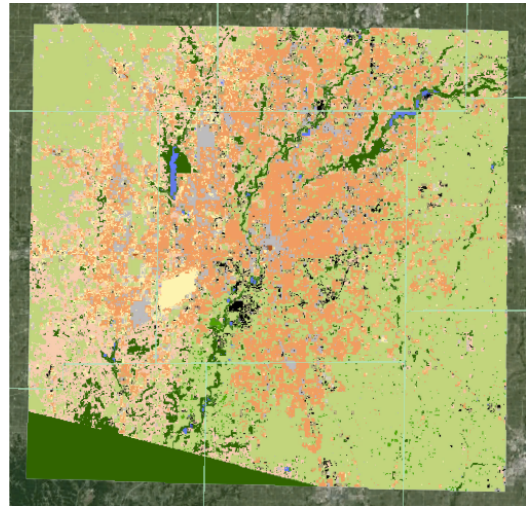
Figure 1: Land use map of Indianapolis and the surrounding area using LCZ framework. The orange represents urban/suburban areas and the green represents rural/forested areas. Map Credit: Oscar Brousse and Anamika Shreevastava, Purdue